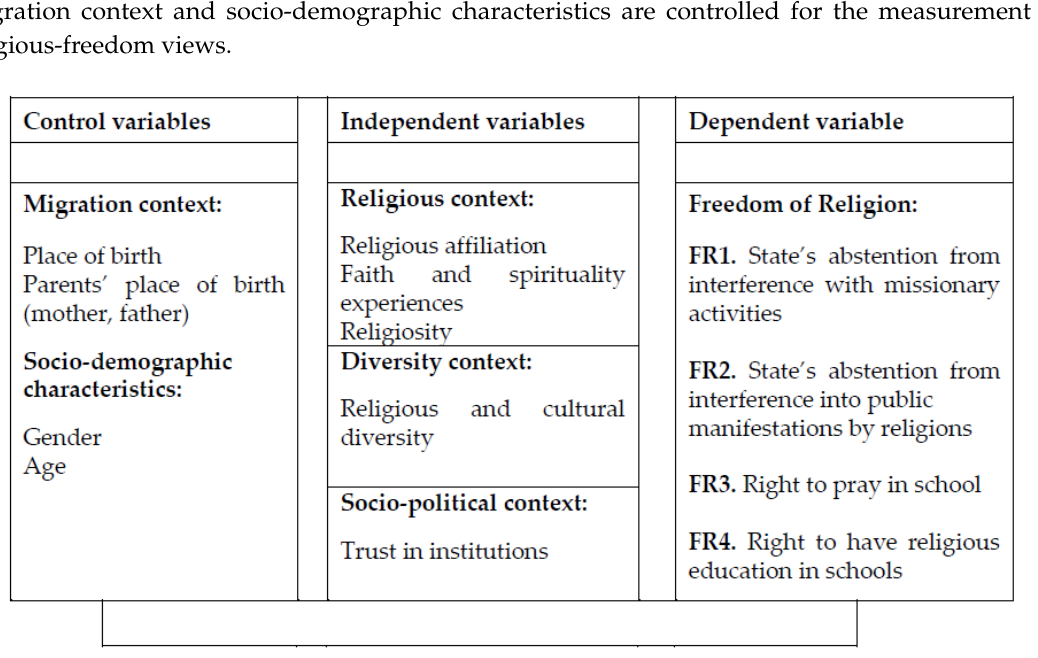
Figure 2. Conceptual model for the analysis of ‘religious freedom’.